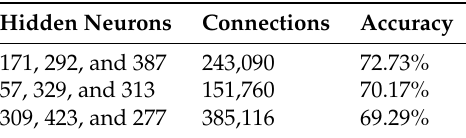
Figure 11. Three executions of optimisation of neural network topologies via an evolutionary algorithm. Table 2. Final results of the three evolutionary searches sorted by 10-fold validation accuracy along with the total number of connections within the network.